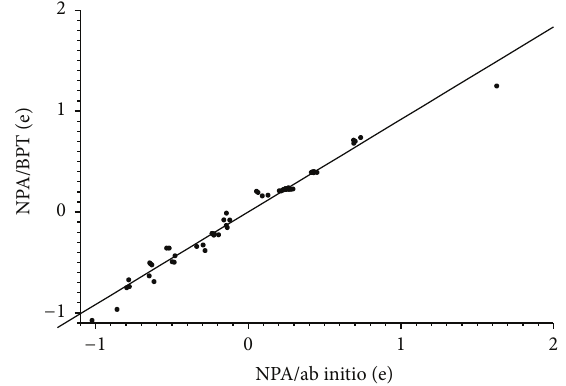
Figure 3: Correlation between BPT atomic charges and DFT char- ges calculated employing theNPAmethod and a 6-31G(d,p)basisset for a pseudopeptide zinc complex not included in the training